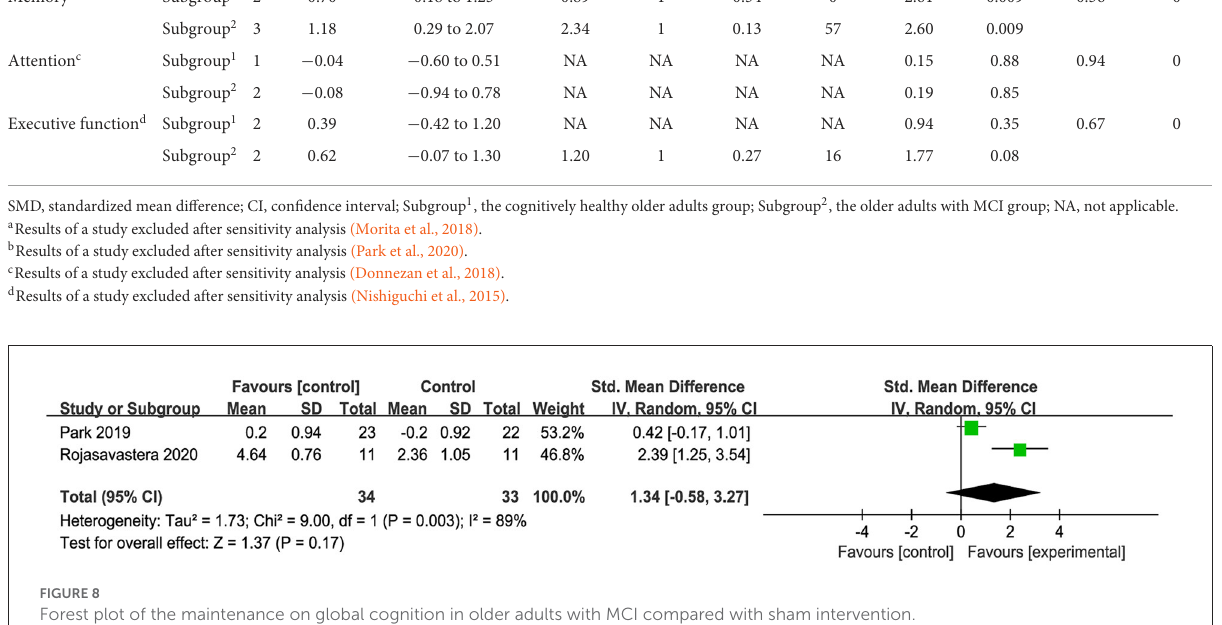
Homogeneity Test for overall 95% CI